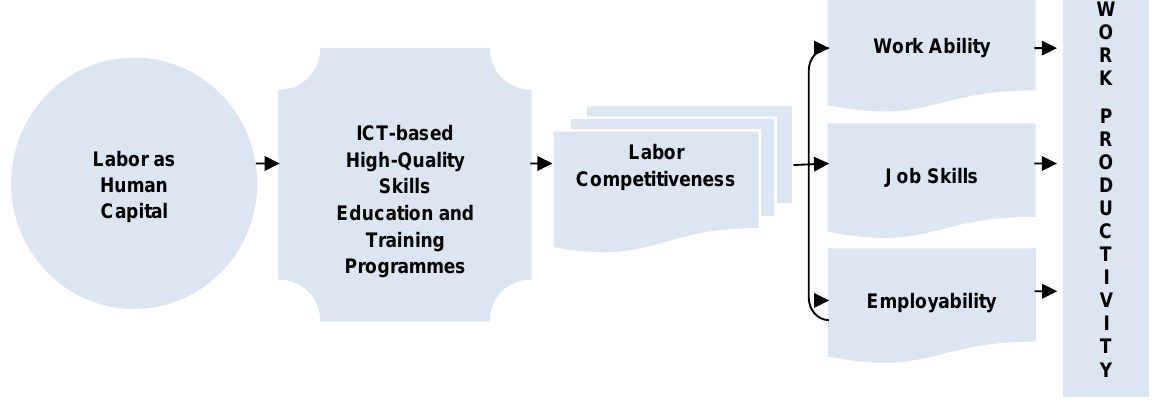
Figure 1: Labor Competitiveness from the Perspective of Human Capital